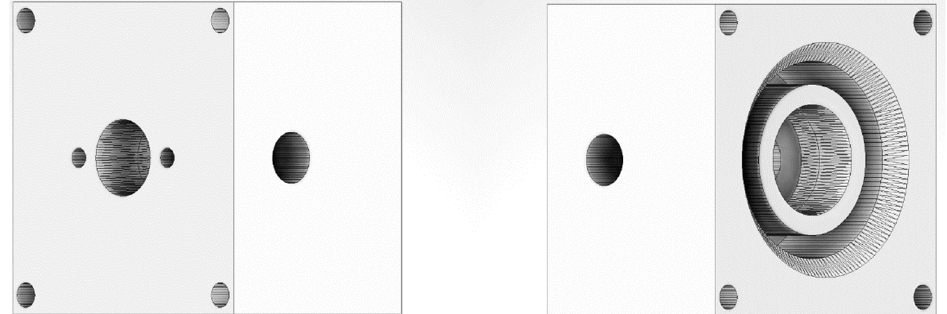
Figure 2. Three-dimensional model of the reversed engineered sensor head. Left — top and back view. Right — front and top view. Model available from source [24].